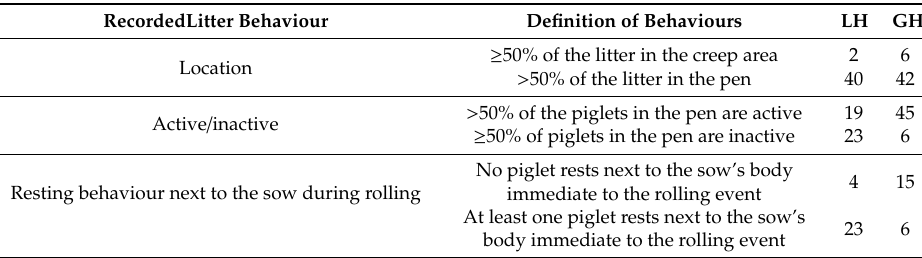
Table 3. Number of recorded litter behaviour during crushing events in single loose housing pens (LH) and pens of the group housing system (GH). Location (LH: n = 42 of 13 litters, GH: n = 48 of 25 litters), active / inactive (LH: n = 42 of 13 litters, GH: n = 51of 25 litters), resting behaviour next to the sow during rolling (LH: n = 27 of nine litters, GH: n = 21 of 15